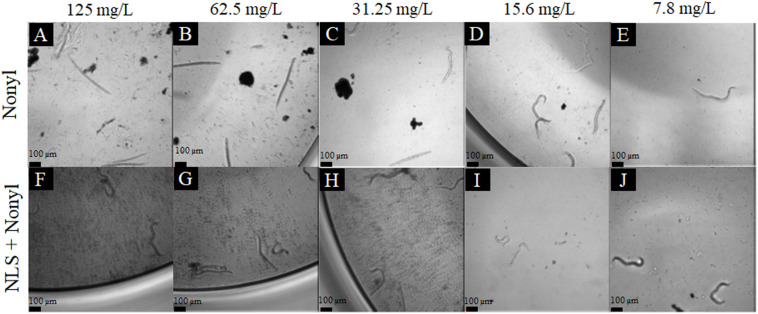
Representative image of C. elegans AU37 larvae treated with nonyl 125 mg/L (A); 62.5 mg/L (B); 31.25 mg/L (C); 15.6 mg/L (D); 7.8 mg/L (E); and NLS + nonyl 125 mg/L (F); 62.5 mg/L (G); 31.25 mg/L (H); 15.6 mg/L (I); 7.8 (J) (10X magnification). At the highest concentrations, the larvae treated with the nanostructured nonyl remained alive, while those treated with non-incorporated nonyl died (stick-shaped larvae were considered dead, while sinusoidal larvae were considered alive).